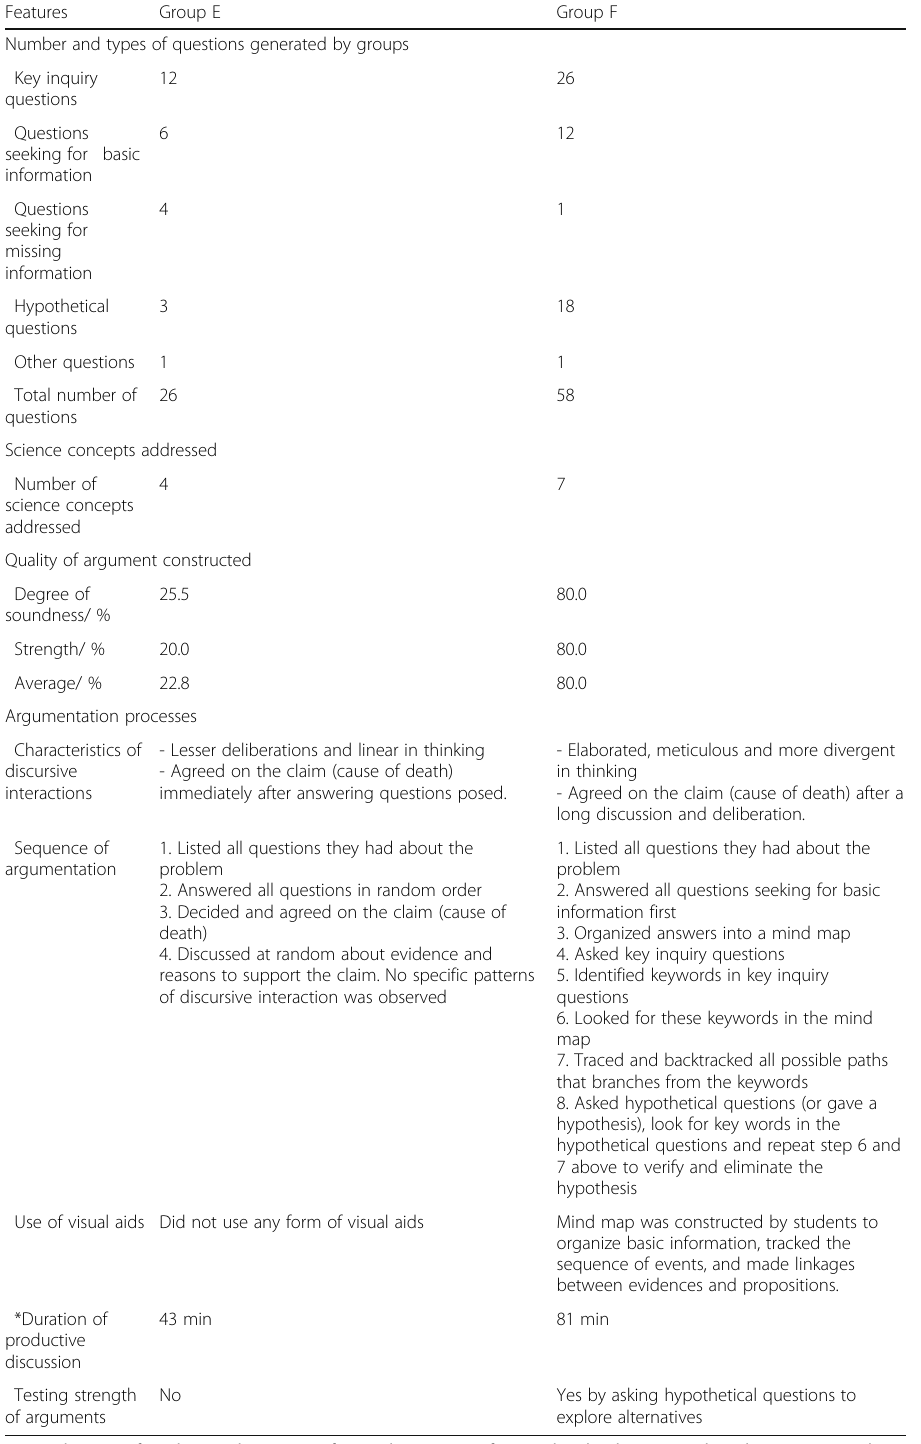
Table 11 Differences between group E and F during argument construction